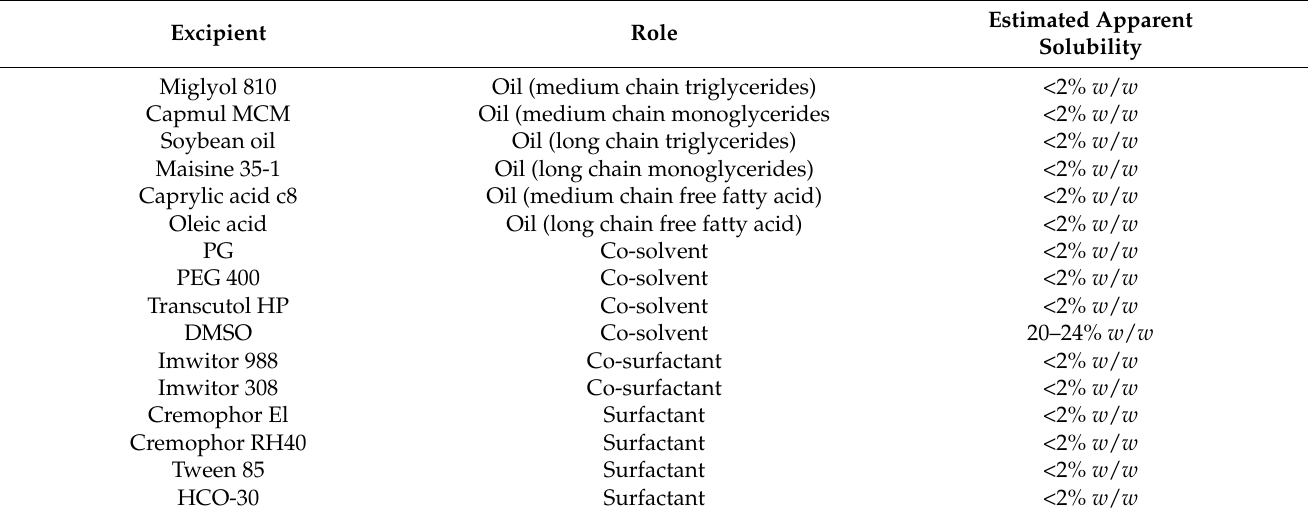
Table 1. Estimated apparent solubility of CPF in various excipients.